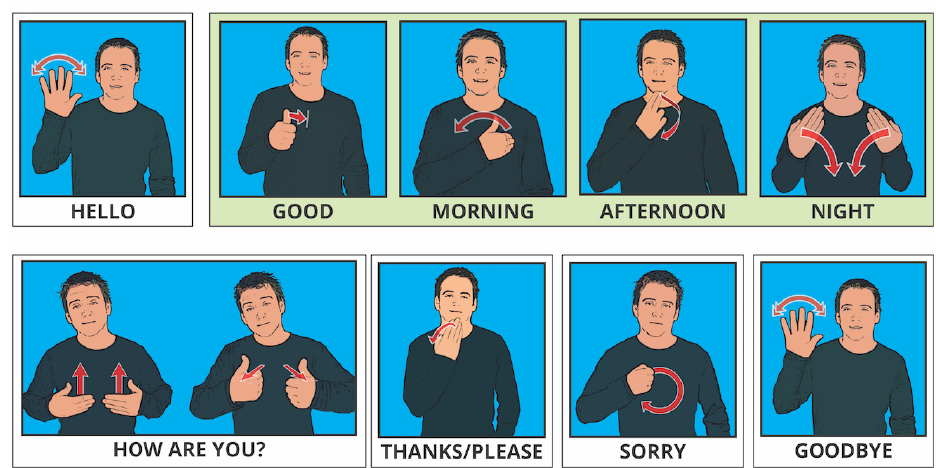
Figure 11. British Sign Language Pose Signs (credits of the picture goes to